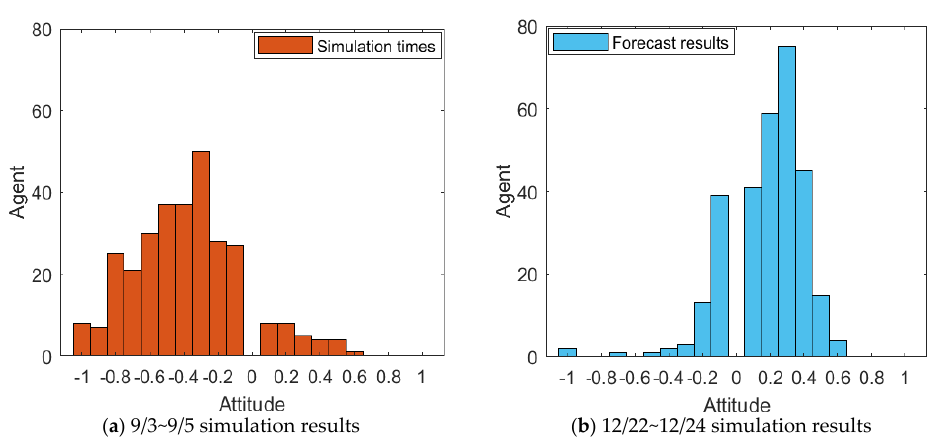
Figure 34. Simulated group attitude distribution histogram based on the literature [14]. ( a ) 9/3~9/5 simulation results; ( b ) 12/22~12/24 simulation results.